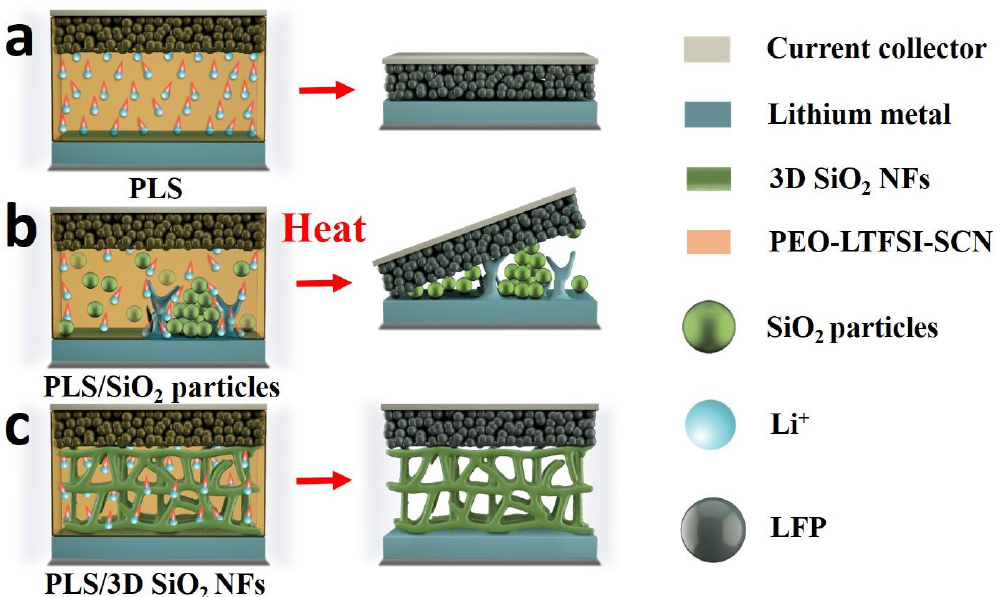
Figure 8. Schematic diagram of cells with ( a ) PLS, ( b ) PLS / SiO 2 particles, and ( c ) PLS / 3D SiO 2 NFs.